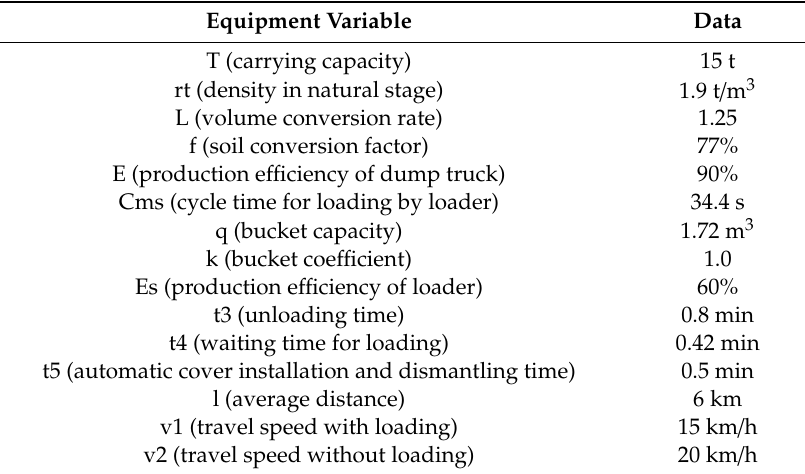
Table 7. Dump truck variable